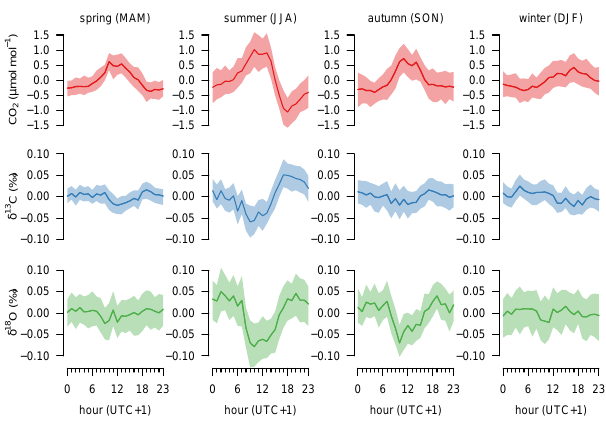
Fig. 8. Mean diurnal cycles as a difference to the daily mean for the different seasons. The shaded area is the 95% confidence interval of the hourly mean derived from bootstrap